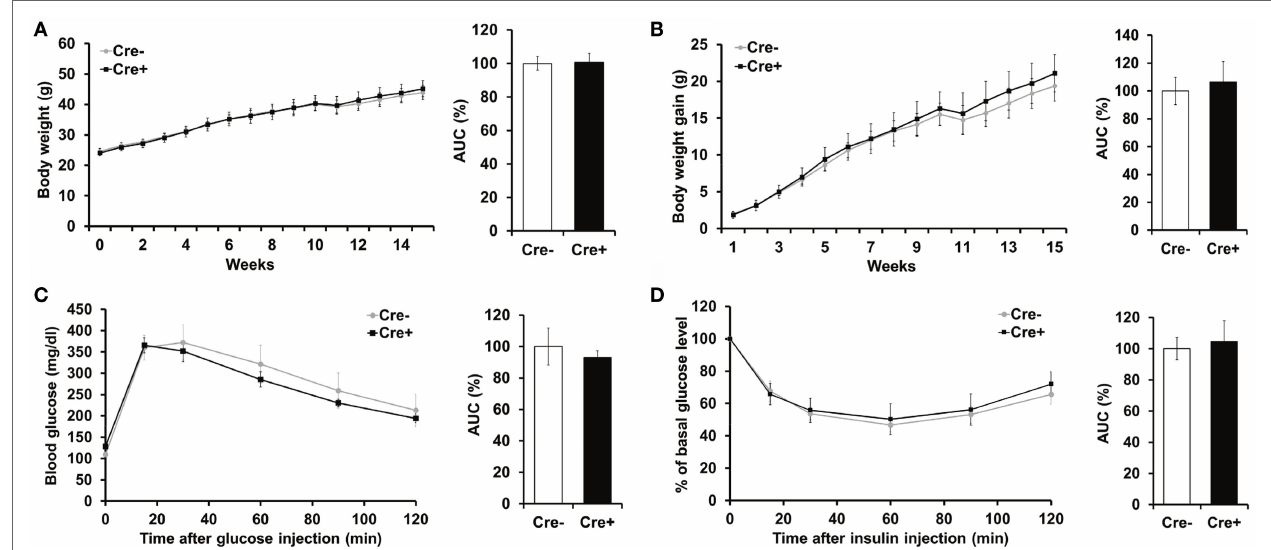
FigUre 1 | Mast cell deficiency in the Kit -independent Mcpt5-Cre R-DTA model does not affect body weight, glucose tolerance, and insulin resistance in diet-induced obesity . (a,B) Mast cell-deficient Mcpt5-Cre + R-DTA + and mast cell-proficient Cre-negative R-DTA + littermate control male mice were fed a HFD and weight (a) and weight gain (B) were recorded. (c,D) Glucose tolerance test (c) and insulin tolerance test (D) were performed in mast cell-deficient Mcpt5-Cre + R-DTA + and mast cell-proficient Cre-negative R-DTA + littermate mice subjected to diet-induced obesity. In (D) , data are presented as percentage of initial glucose level. Data and corresponding area under curve (AUC) analysis are shown. AUC data are presented as % of control; the Cre-negative group was set as the 100% control. AUC data were tested for statistical significance with Student’s t -test. Data are expressed as means ± SEM ( n = 8–10